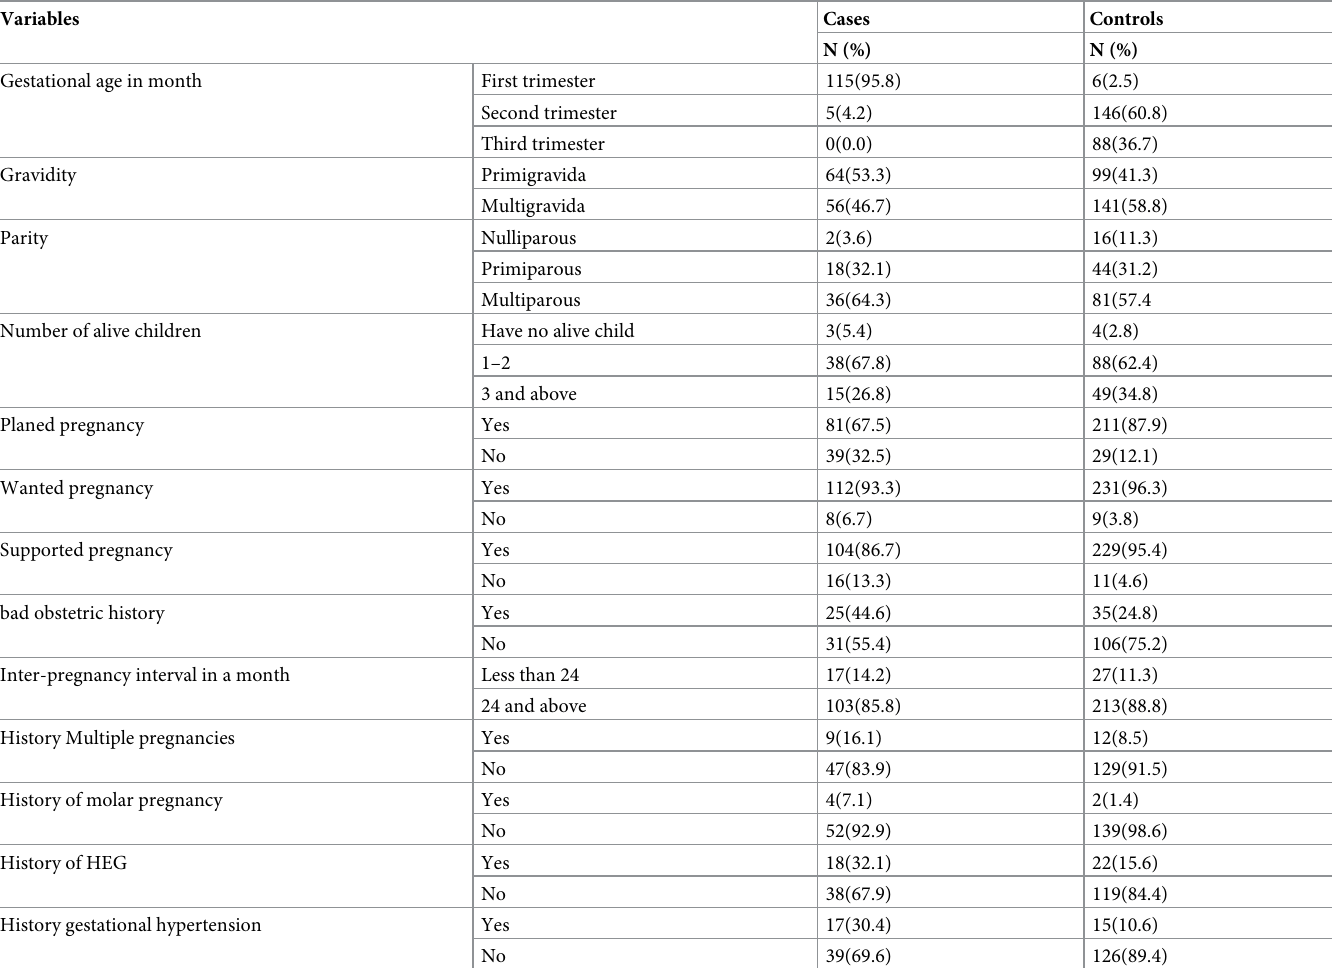
Table 2. Obstetric characteristics of pregnant women attending health care service in public hospitals, southern Ethiopia, 2021.